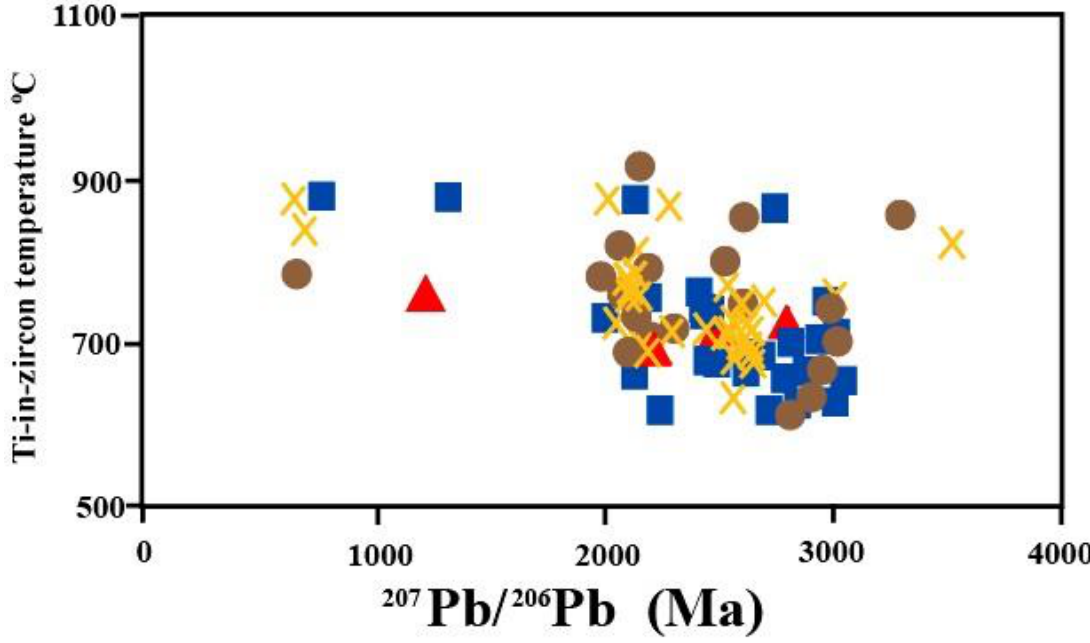
Figure 12. Ti-in-zircon temperature (°C) versus 207 Pb/ 206 Pb ages (Ma) showing correlations within some zircons from the southern Meiganga gold-bearing placers.